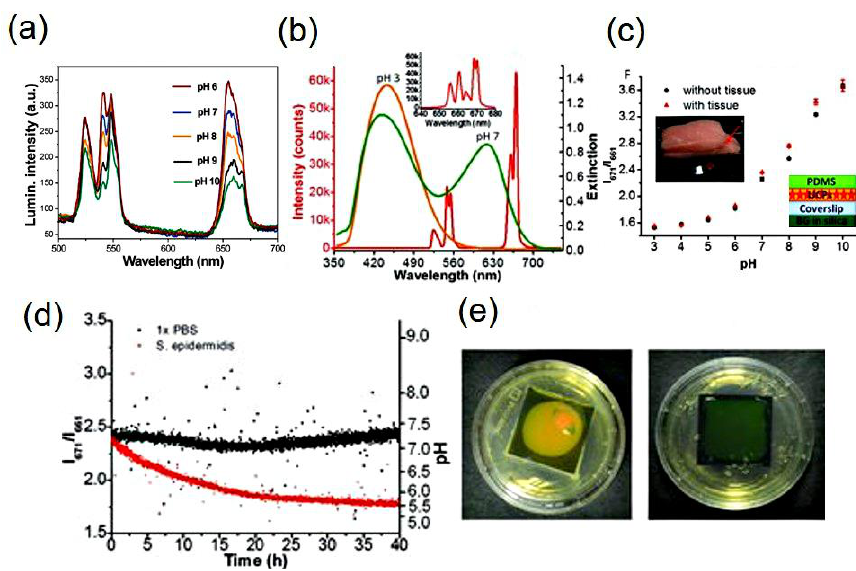
Figure 3. ( a ) pH-dependent upconversion emission spectra of bromothymal blue conjugated NaYF 4 :Er 3+ /Yb 3+ film upon 980 nm excitation (Reproduced from Ref. [78] with permission from The Royal Society of Chemistry). ( b ) The upconversion spectrum of Y 2 O 2 S:Er 3+ /Yb 3+ UCNPs (red line, left y -axis) and the extinction spectra (right y -axis) of bromocresol green-doped silica films in pH 3.0 (orange) and buffer 7.0 (green). Inset shows the red luminescence with higher resolution. ( c ) The calibration curves of bromocresol green conjugated Y 2 O 2 S:Er 3+ /Yb 3+ films, without (black dots) and with (red points) passing through porcine tissue. Left inset shows the photograph of the sensor film sandwiched between two porcine tissues for pH calibration. The inset in the right side shows the schematic representation of the pH sensor. ( d ) pH determination in real-time with the sensor film passing through porcine tissue. The red dots exhibit the variation of pH due to the bacterial development at the interface of the TSA plate and pH-sensor; the black dots show the variation of pH of the controlled sample with same volume of phosphate buffer solution. The corresponding pH values, calculated according to the calibration curve, are shown in the right y -axis. ( e ) The photograph at the left side shows the pH sensor film by the end of the real-time experiment with S. epidermidis and at the right side shows the film of the control sample by the end of acquisition (Figure 3b–d: Reproduced from Ref. [34] with permission of John Wiley & Sons